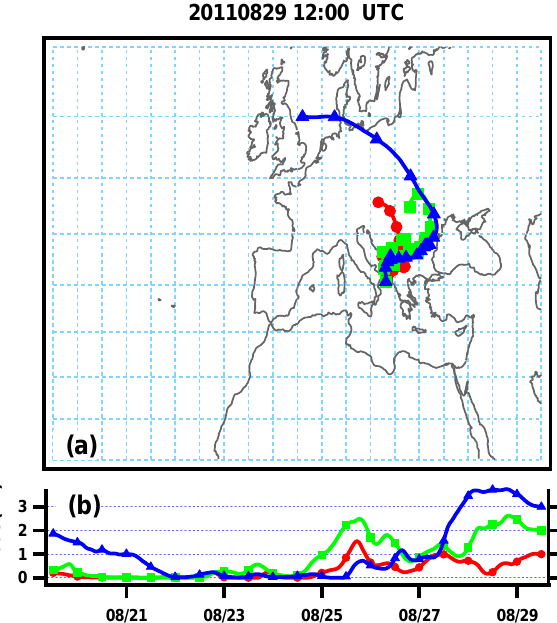
Fig. 7. (a) Pathways of the ten-day HYSPLIT back trajectories of 29 August 2011 estimated at 12:00UTC, each with arrival heights at 1, 2, and 3kma.g.l. (b) Time evolution of the altitude of each back